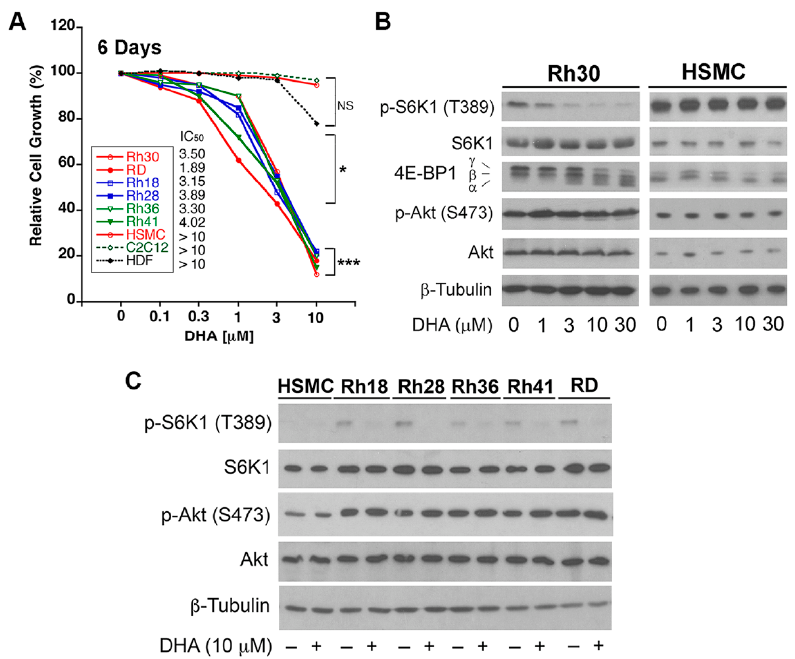
Figure 1. Dihydroartemisinin (DHA) inhibits the proliferation of rhabdomyosarcoma (RMS) cells. ( A ) Indicated cell lines were exposed to DHA (0 − 10 μ M) for 6 days, followed by cell counting using a Beckmann Coulter counter. The results are shown as mean values ( n = 3). NS, not significant; * p < 0.05; *** p < 0.001; difference versus vehicle control group. ( B , C ) Indicated cells were treated with DHA at indicated concentrations for 24 h, followed by Western blotting with indicated antibodies.